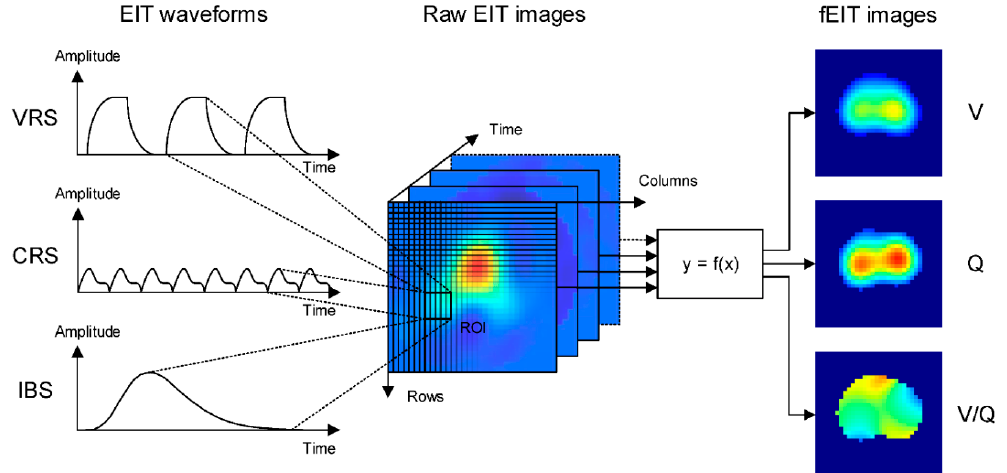
Figure 3. EIT waveforms and functional EIT (fEIT) images are derived from the raw EIT images. EIT waveforms can be defined pixel-wise or on a region of interest (ROI). Conductivity changes result naturally from ventilation (VRS) or cardiac activity (CRS) but can also be induced artificially, e.g., by bolus injection (IBS) for perfusion measurement. fEIT images display regional physiological parameters, such as ventilation (V) and perfusion (Q), extracted from the raw EIT images using a mathematical operation over time.